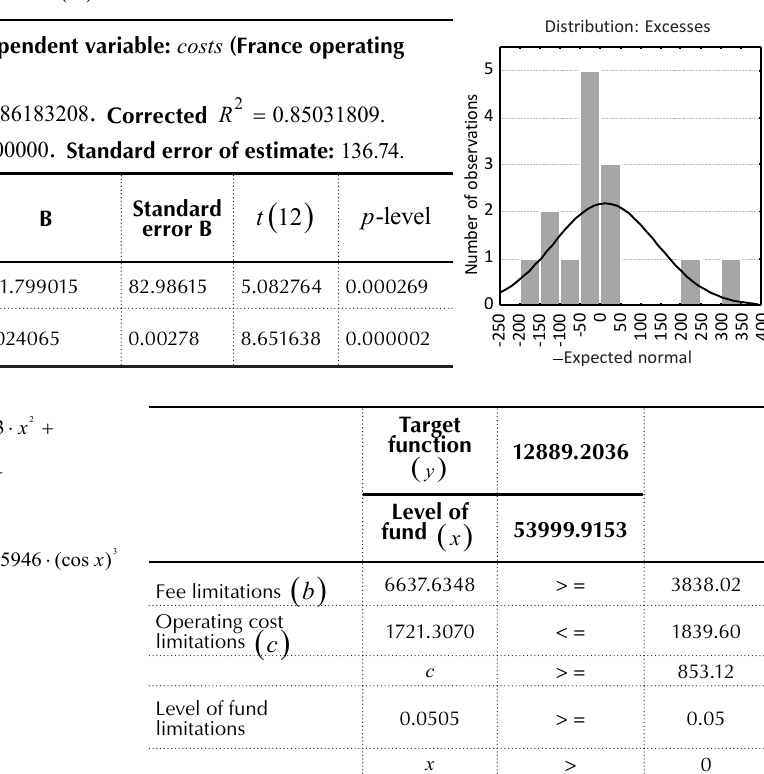
Table 6c. The results of regression for operating costs of Investor Compensation Company Limited (Ireland) ( ) e from the fund’s volume ( )